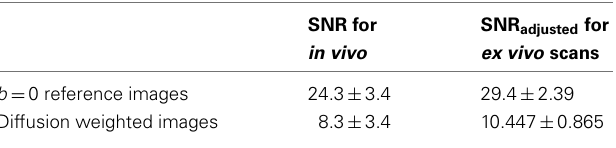
Table 3 | Signal to noise ratio comparison between the in vivo and the ex vivo DTI